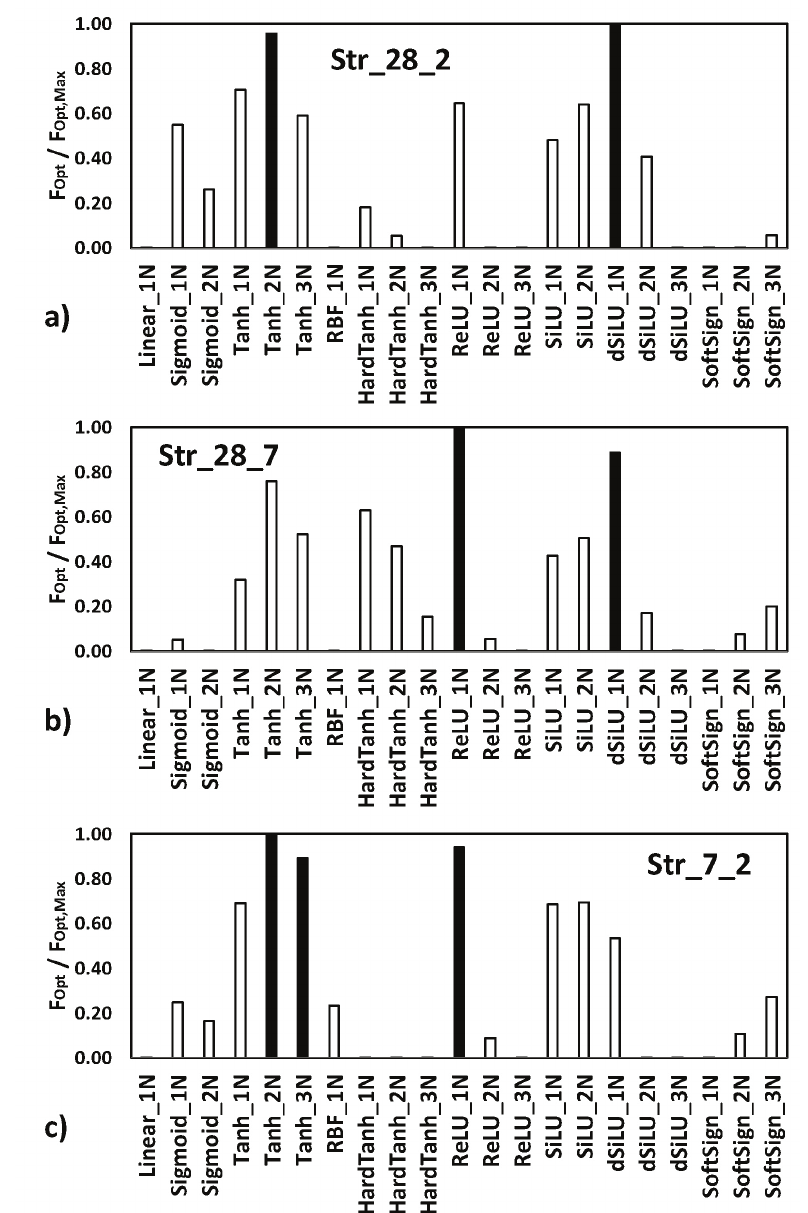
Fig. 13 – R ratios for the models a) Str_28_2, b) Str_28_7, and c) Opt